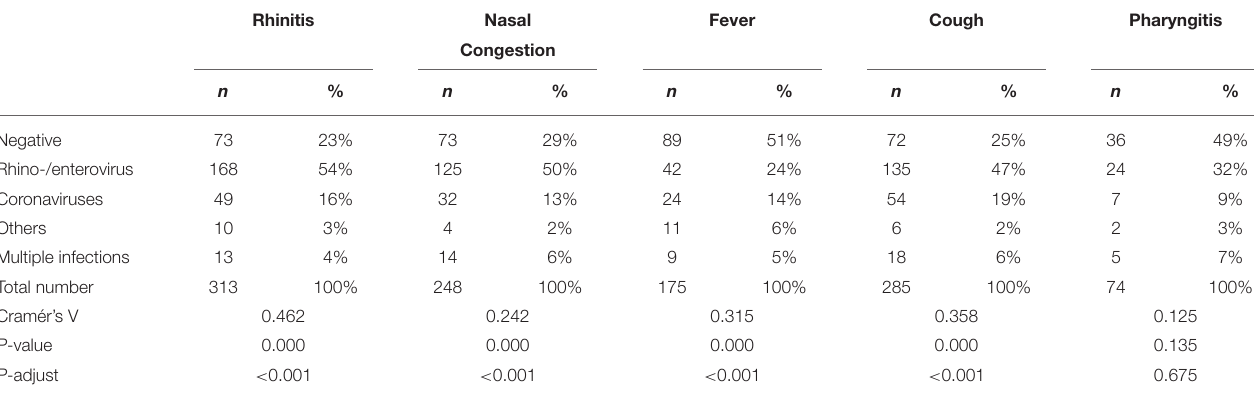
TABLE 3 | Distribution of pathogens within the symptom category. Rhinitis Nasal Fever Cough Pharyngitis